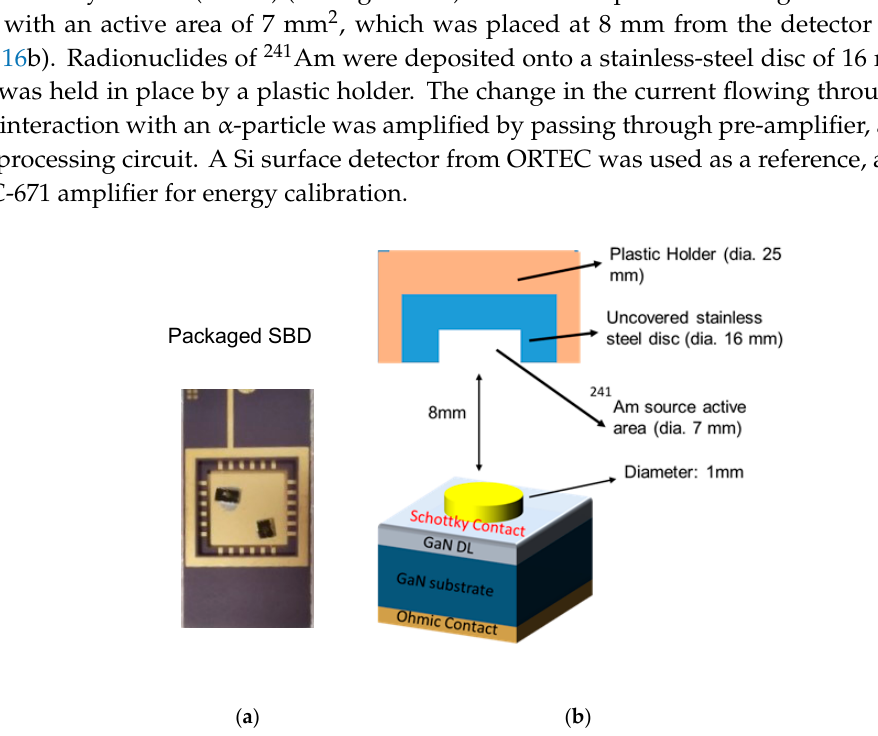
Figure 16. ( a ) Packaged Device and ( b ) Schematic drawing of Source-Detector measurement setup (not to scale).